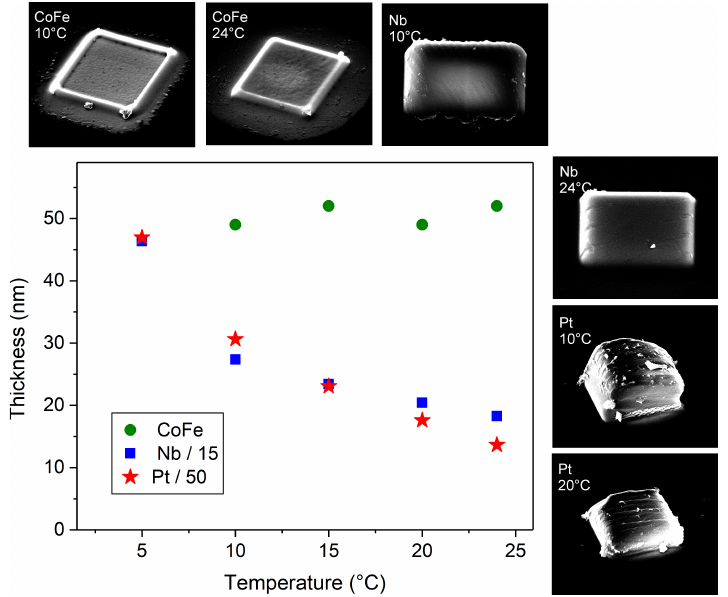
Figure 1. Thickness vs. temperature of samples grown at 5keV and 1.6nA beam current (experiment a ). Green points: samples fabricated with the CoFe-precursor. Blue squares: samples grown using the Nb-precursor. Red stars: deposits grown with the Pt-precursor. Distributed about the main panel, a selection of scanning electron microscope (SEM) images is shown for samples fabricated at the substrate temperatures as